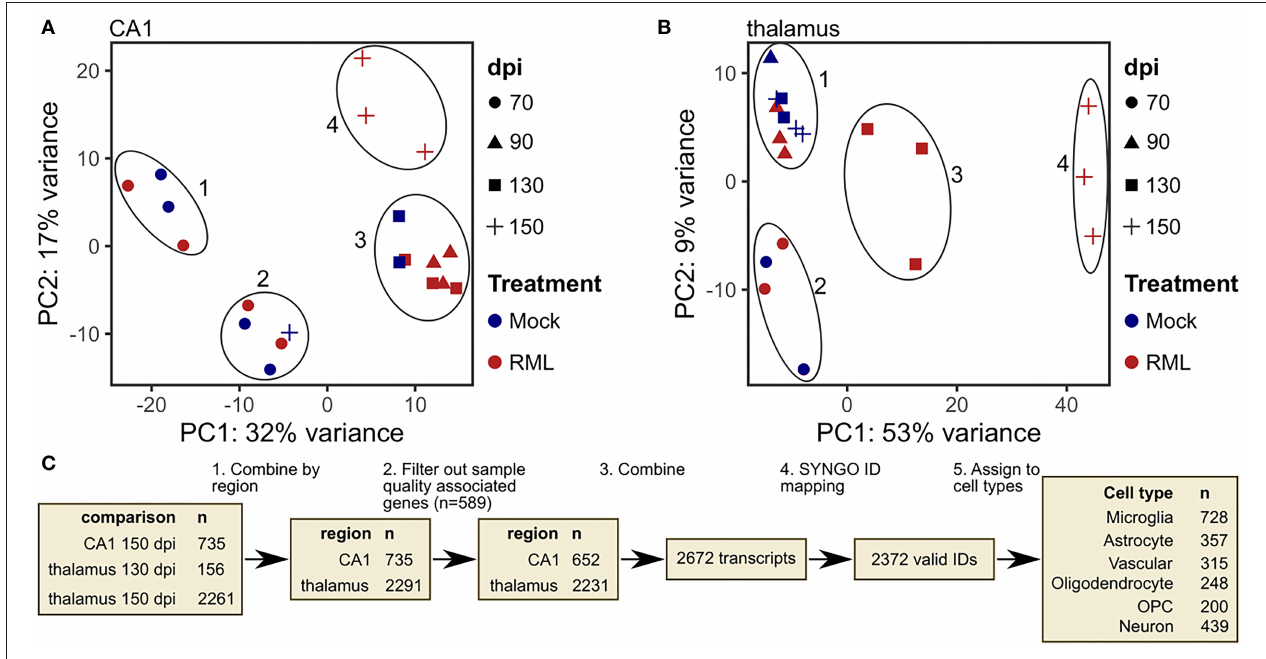
FIGURE 3 | Identification of transcripts with altered abundance in microdissected CA1 and thalamus tissues from RML infected mice. (A) Principle component analysis (PCA) plot of microdissected CA1 tissues used for differential expression analysis with color mapped to treatment and shape indicating days post infection (dpi). (B) PCA plot of microdissected thalamus tissues used for differential expression analysis with color mapped to treatment and shape indicating dpi. (C) Schematic representation of workflow used to identify prion altered transcripts and classify them based on brain cell